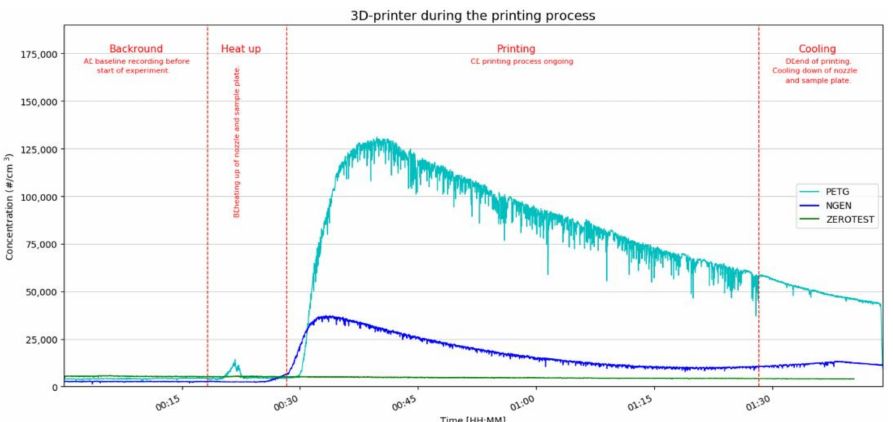
Figure 3. Values of the total particle number concentration during printing with glycol modified polyethylene terephthalate (PETG) + styrene free co-polyester (NGEN) filaments + zero test.